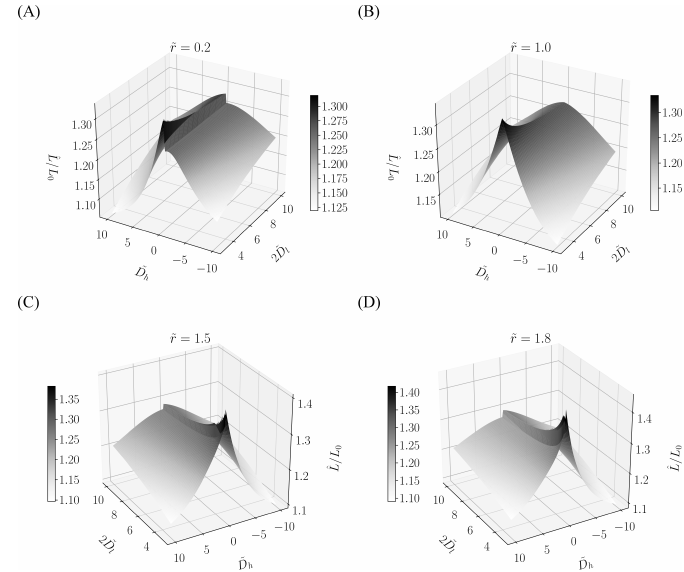
Figure 11. ˆ L / L 0 when ˜ r =